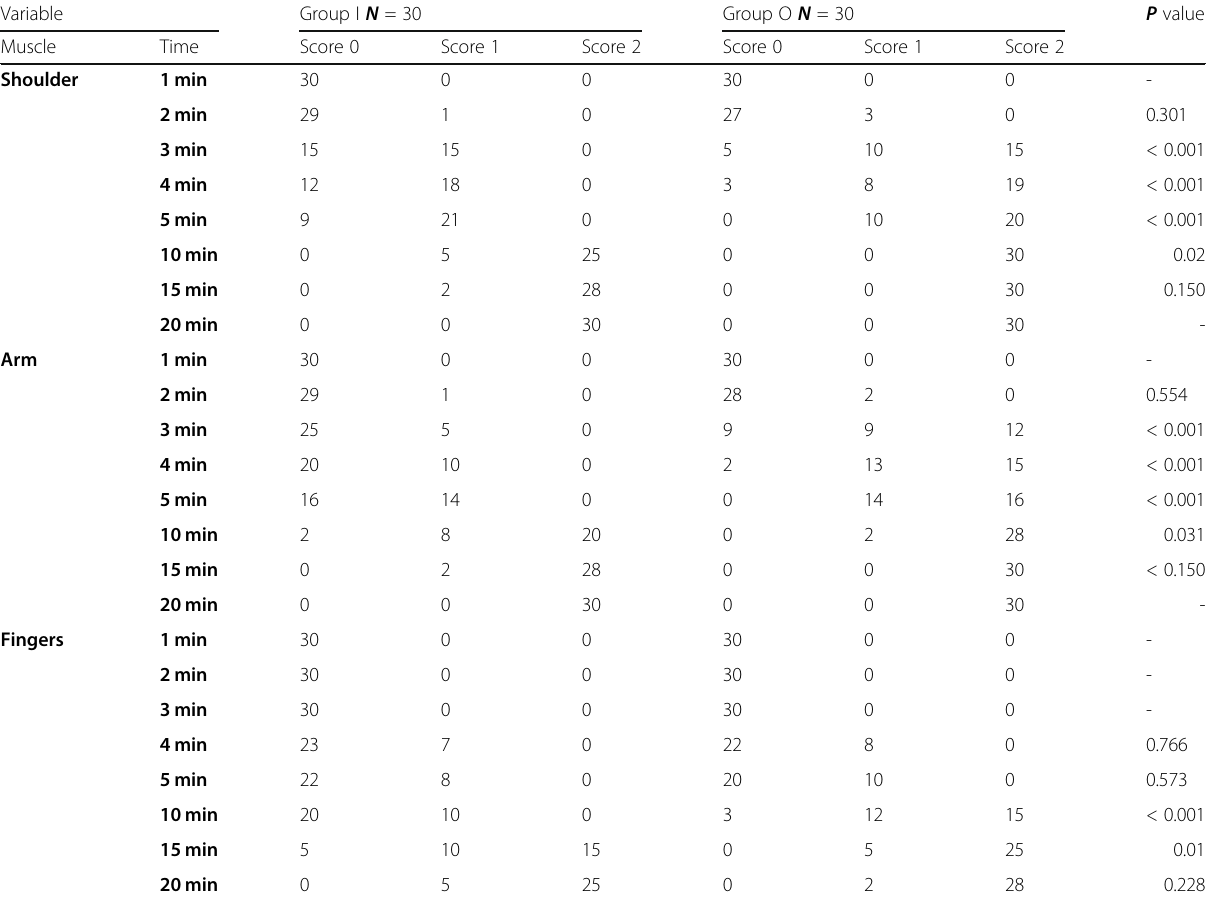
Table 5 Onset and progression of the motor block over the first 20 min